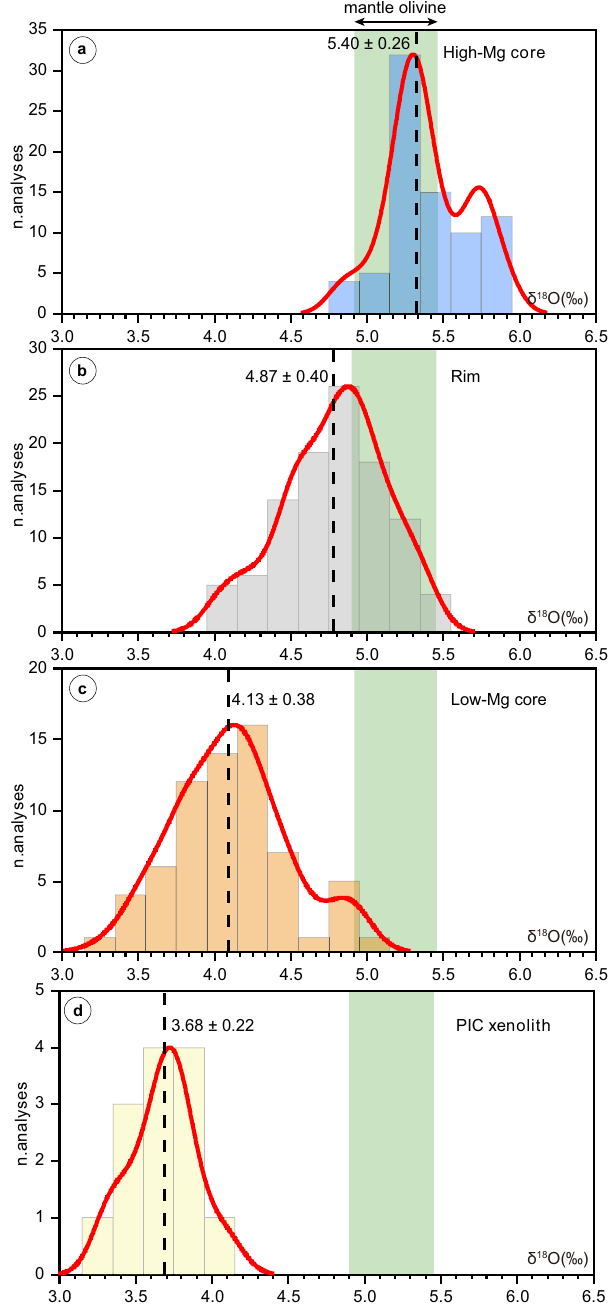
Fig. 4 Probability distribution plots of oxygen isotope compositions in olivine from this study. a High-Mg olivine cores, b olivine rims, and c low- Mg olivine cores in the examined kimberlites and lamproites, and d olivine in PIC-like xenoliths. The dashed lines and associated numbers (±1 standard deviation) indicate average δ 18 O values for each probability distribution plot. Green bands represent the mantle olivine value (5.18 ± 0.28 ‰ ; see ref. 3